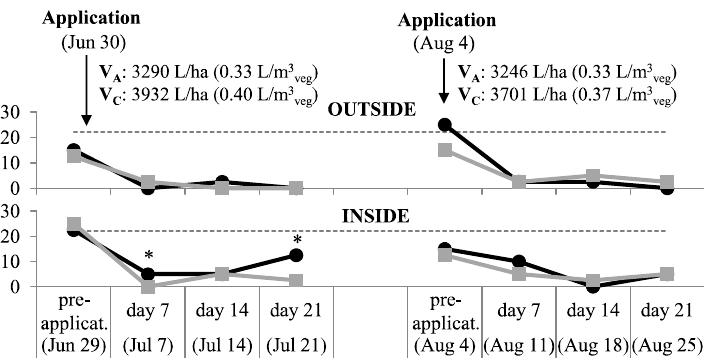
Figure A2. Symptomatic leaves occupied by Tetranychus urticae (%, mean) at two depths of the canopy (outside, inside), pre ‐ application and after the applications (at 7, 14 and 21 DAA) with two different spray volumes (V A : adjusted, V C : conventional) and in different plots (P1–P7). The water volume is indicated in L/ha and L/m 3vegetation . The dotted line indicates the treatment threshold: 22% of symptomatic leaves occupied. The percentage of symptomatic leaves occupied by Tetranychus urticae in V A and V C treatments groups was compared with a chi ‐ square test. The asterisk (*) indicates significant differences between volumes (chi ‐ square test; p = 0.05).